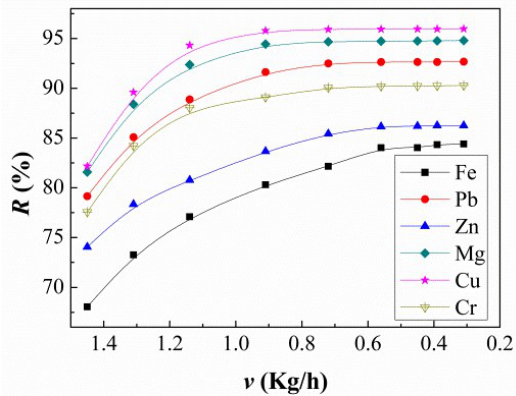
Figure 5. Effect of solidification rate v on the removal ratio for the impurities R %.